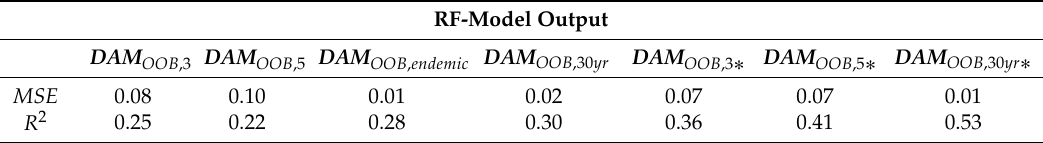
Table 4. Summary of out-of-bag- MSE and - R 2 calculated from RF-model output.